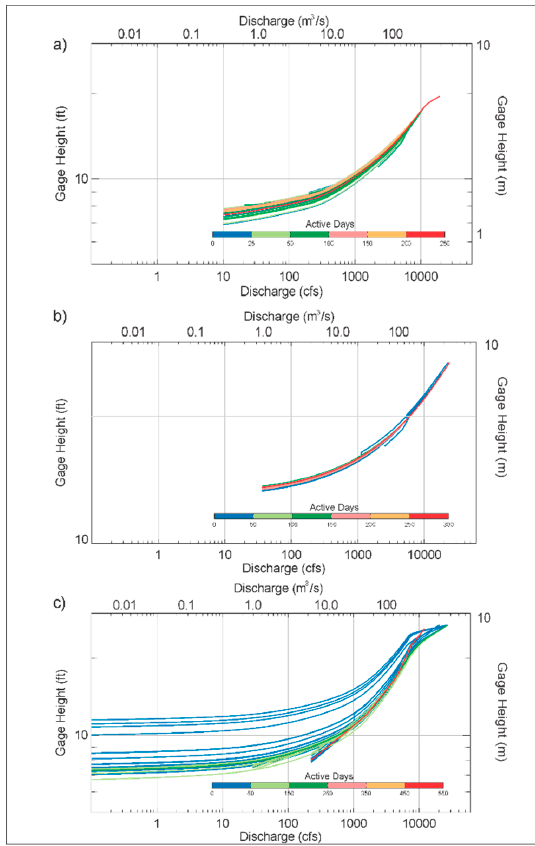
Figure 17. Duration of each rating curve (in days). ( a ) Shell Rock River near Rockford; ( b ) Cedar River at Osage; and ( c ) West Nishnabotna River near Riverton.